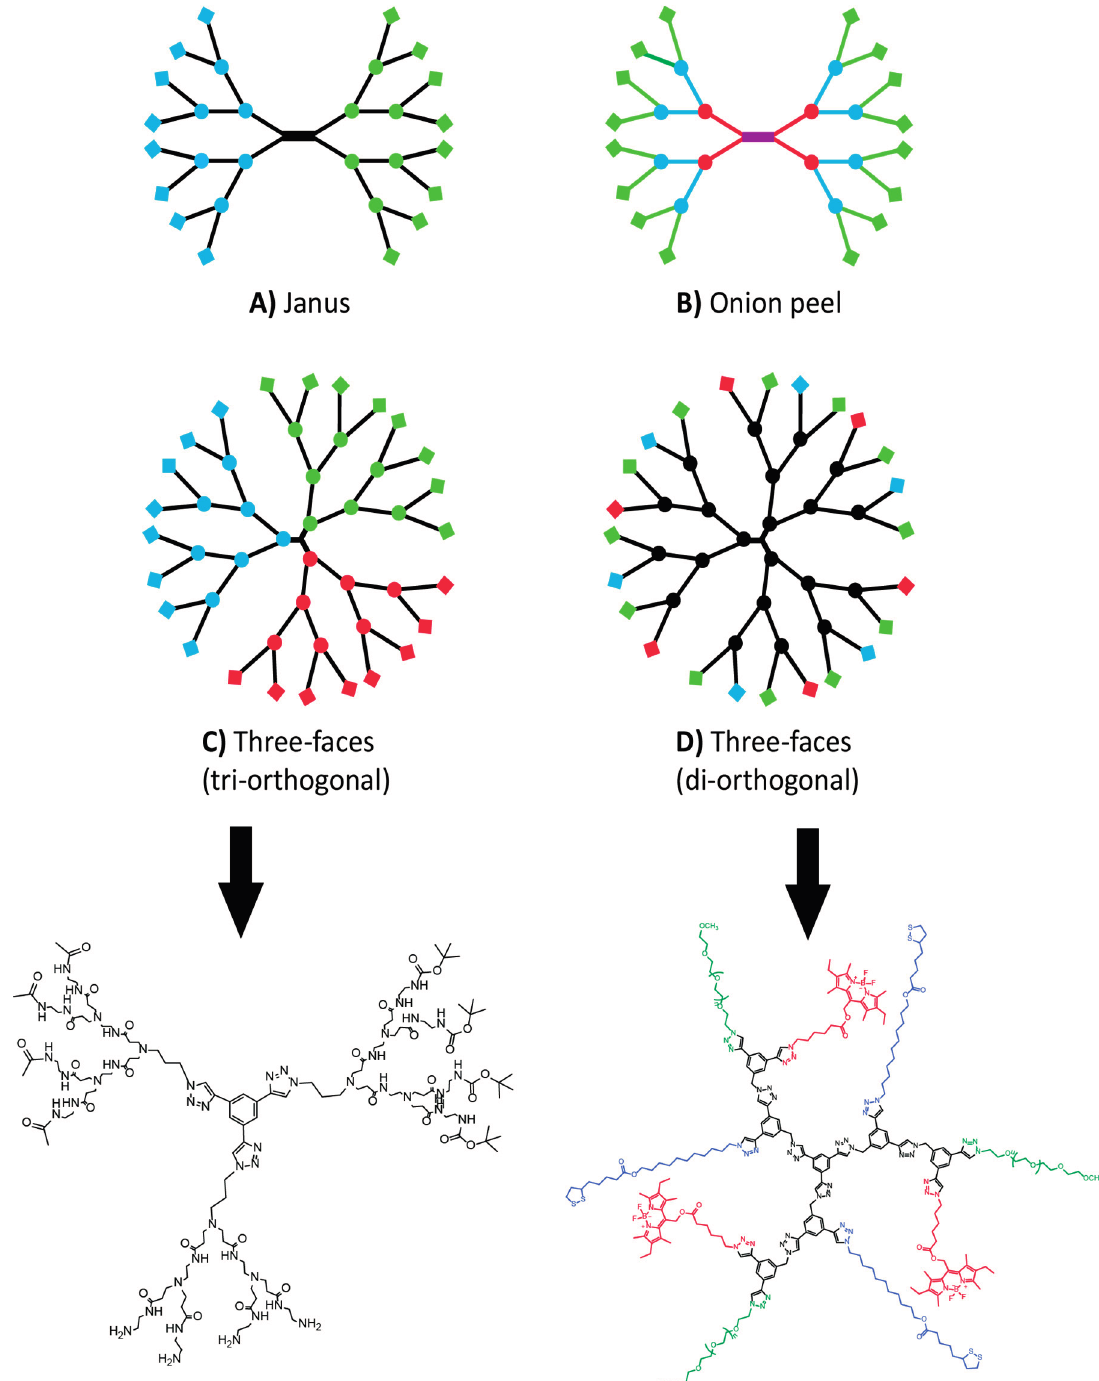
Figure 4. Complex dendritic architectures evolution from the pre-existing Janus ( A ) to the “onion peel” ( B ) and the three-faces strategies that rely on tri-orthogonality ( C ) or di-orthogonality ( D ).The structures of C and D are shown below to highlight how CuAAC was used only at the core for C and within the branches for